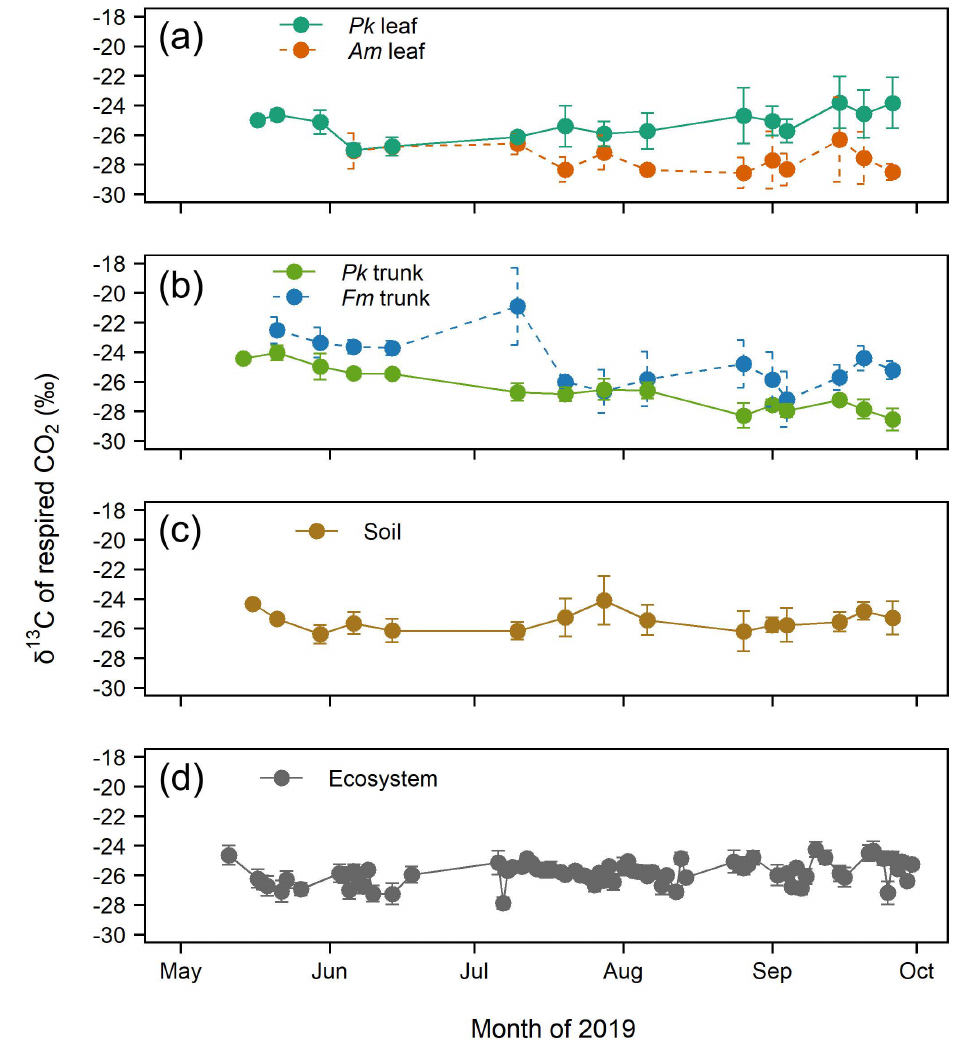
Figure 4. Seasonal variations in the δ 13 C R of leaves ( a ), trunks ( b ), and soil ( c ), and in δ 13 C eco ( d ). δ 13 C R and δ 13 C eco were both derived using the Keeling plot method. The δ 13 C R of leaves, trunks, and soil were averaged from four measurements between 7:00 and 18:00, and the error bars indicate standard deviation. δ 13 C eco was determined from the nighttime (21:00–03:00) CO 2 and δ 13 C air profiles, and the error bars indicate standard errors of the intercept of the Keeling plot. Pk , Korean pine ( P. koraiensis ); Fm , Manchurian ash ( F. mandshurica ); Am , Mono maple ( A. mono ); Qm , Mongolian oak ( Q. mongolica